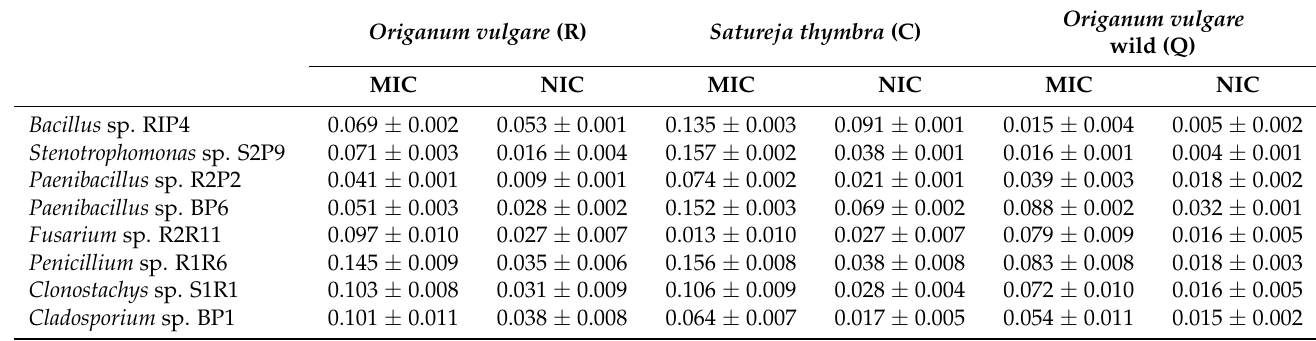
The results differed in terms of fungi. The minimum MIC value of 0.013% v / v was detected for Fusarium sp. R2R11, for Satureja thymbra (C) essential oil, which was much lower compared to the other two tested essential oils of Origanum vulgare (R and Q), with the respected MIC values of 0.097% v / v and 0.079% v / v (Table 5). For Penicillium sp. R1R6, the lower MIC value was noticed for Origanum vulgare wild (Q) (0.083% v / v ), followed by those of Origanum vulgare (R) (0,145% v / v ) and Satureja thymbra (C) (0.156% v / v ).